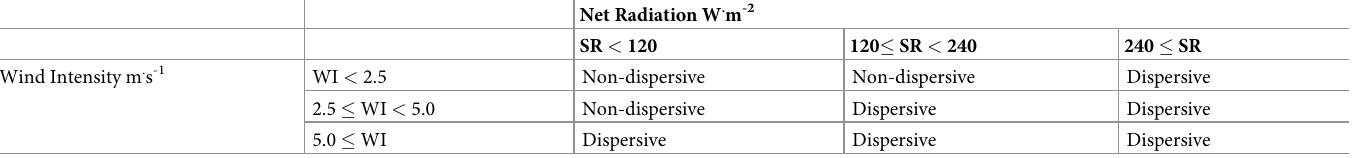
Table 1. Meteorological conditions. Features describing dispersive and non-dispersive